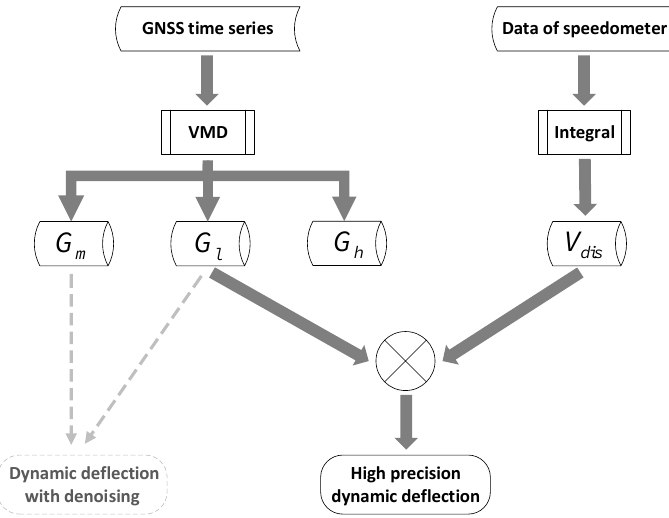
Algorithm 2: Evaluate the Accuracy of Time Synchronization